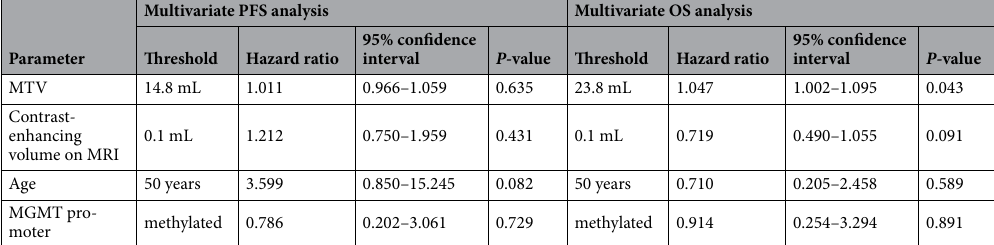
Table 4. Results of multivariate survival analyses. FLAIR fluid attenuated inversion recovery, MGMT O 6